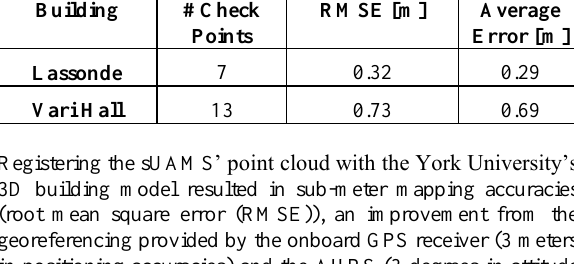
Table 1: Accuracy assessment of the generated point clouds